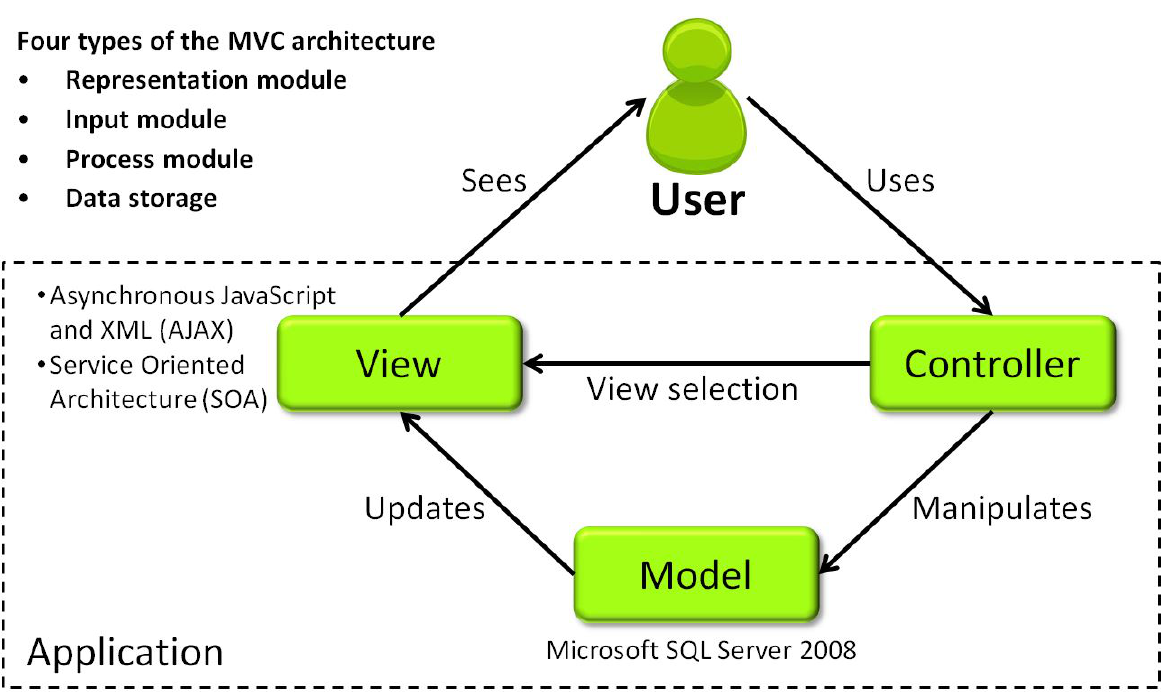
Figure 3. The high-level description of the user-environment system architecture, Model-View-Controller (MVC). Based on the MVC architecture, the modules of the platform can be clean, flexible, reusable, and extendable for